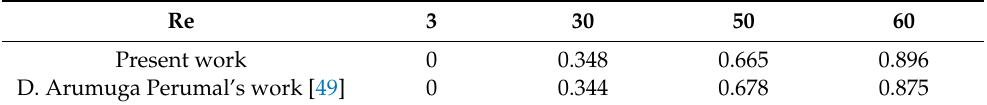
Table 1. For four Reynolds values, the length of the recirculation area was measured. The measured length of the recirculation layer divided by D is used to express the length data here.